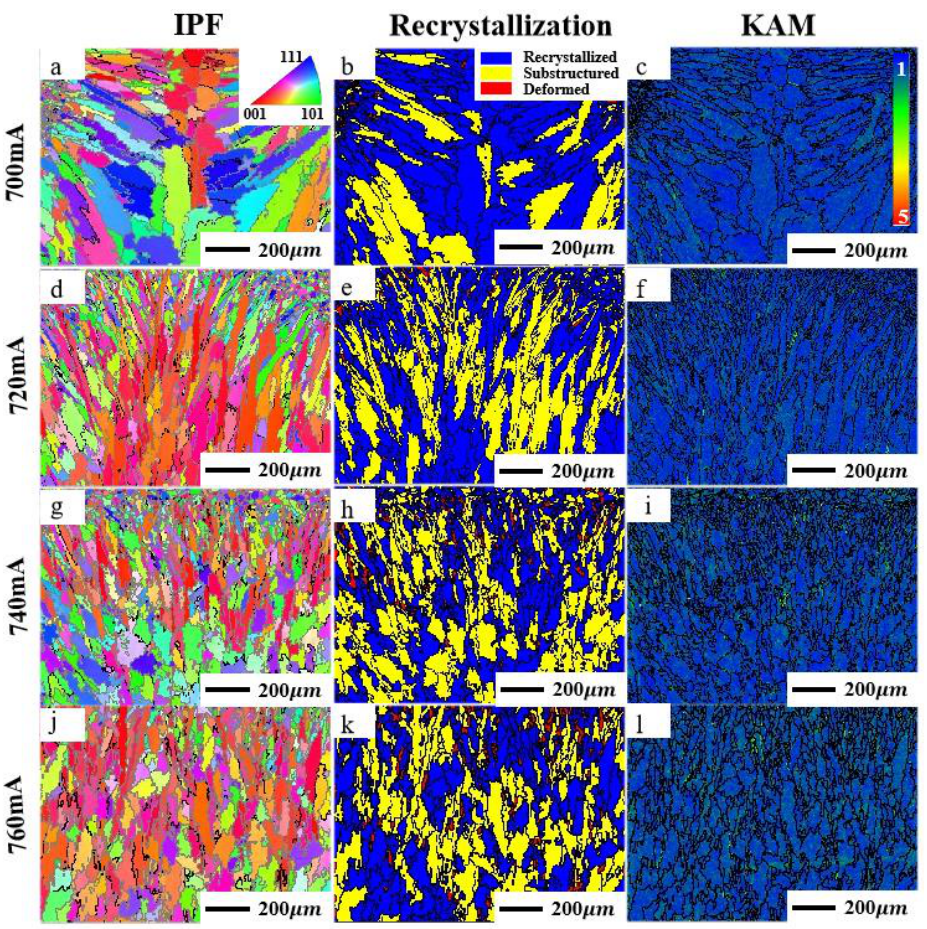
Figure 10. Inconel 625 IPF, recrystallization, and KAM diagrams under different focusing current scanning conditions: ( a,b,c ) 700 mA; ( d,e,f ) 720 mA; ( g,h,i ) 740 mA; ( j,k,l ) 760 mA.